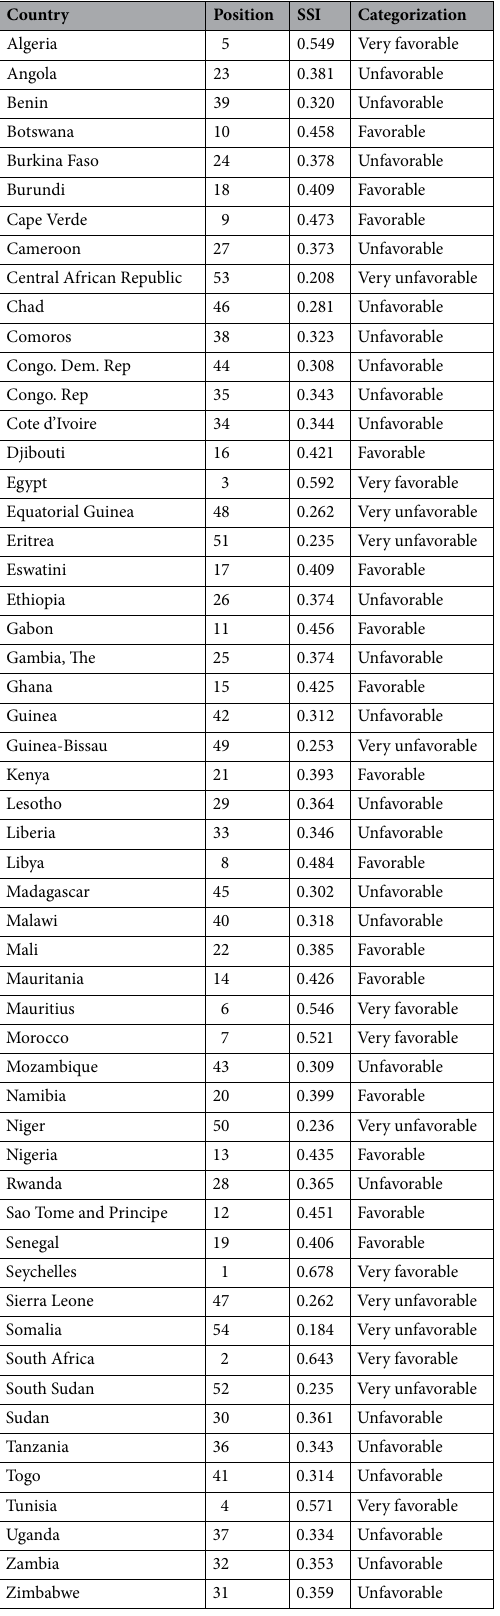
Table 3. Synthetic Sustainability Index (SSI), position and categorization of each African Country. Synthetic sustainability index categorized in very favorable (> 0.487); favorable (0.487–0.381); unfavorable (0.381–0.275); very unfavorable (<